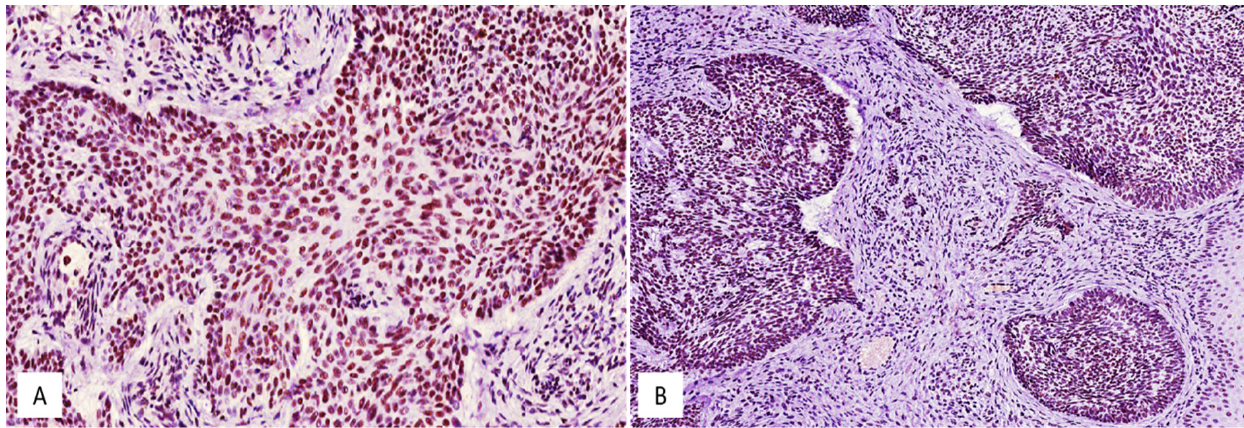
Figure 1. High ( A ) and low ( B ) immunohistochemical expression of SRSF1 in conventional basal cell carcinomas; immunoperoxidase, original magnifications 200× ( A ) and 150× ( B ).